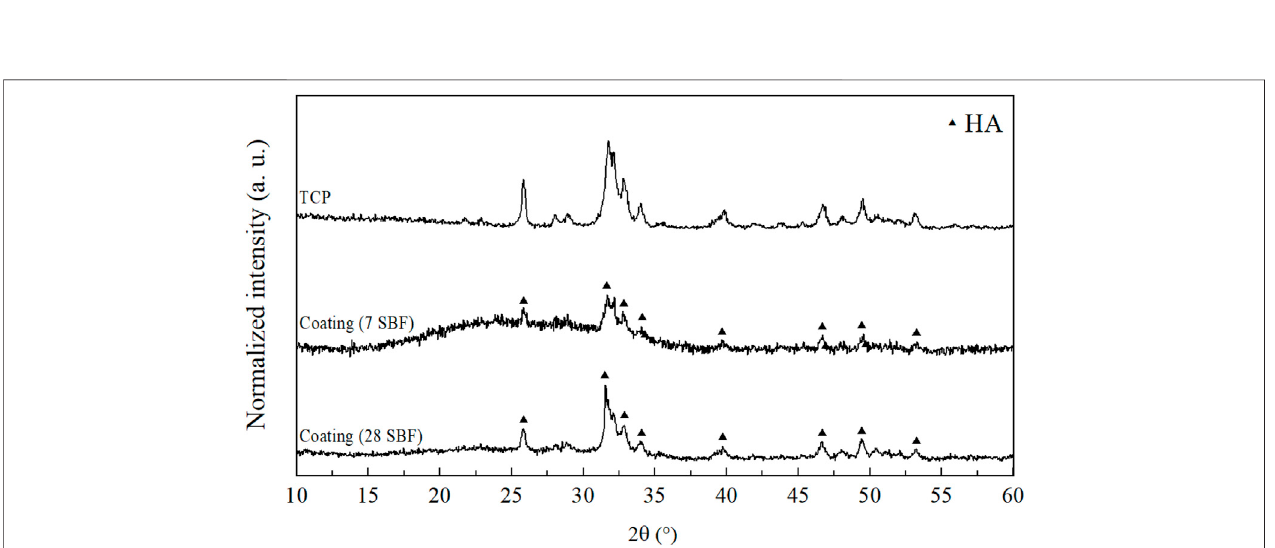
FIGURE 7 | Normalized FTIR-ATR spectra of coatings before and after soaking in SBF solution.